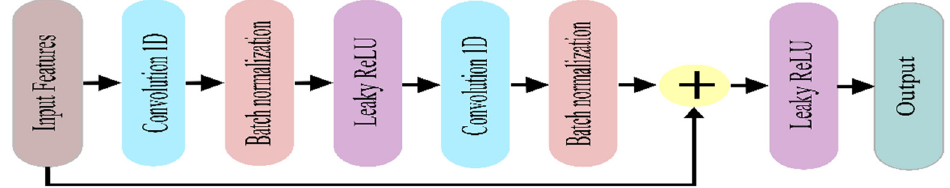
Figure 6. The schematic diagram of residual block.